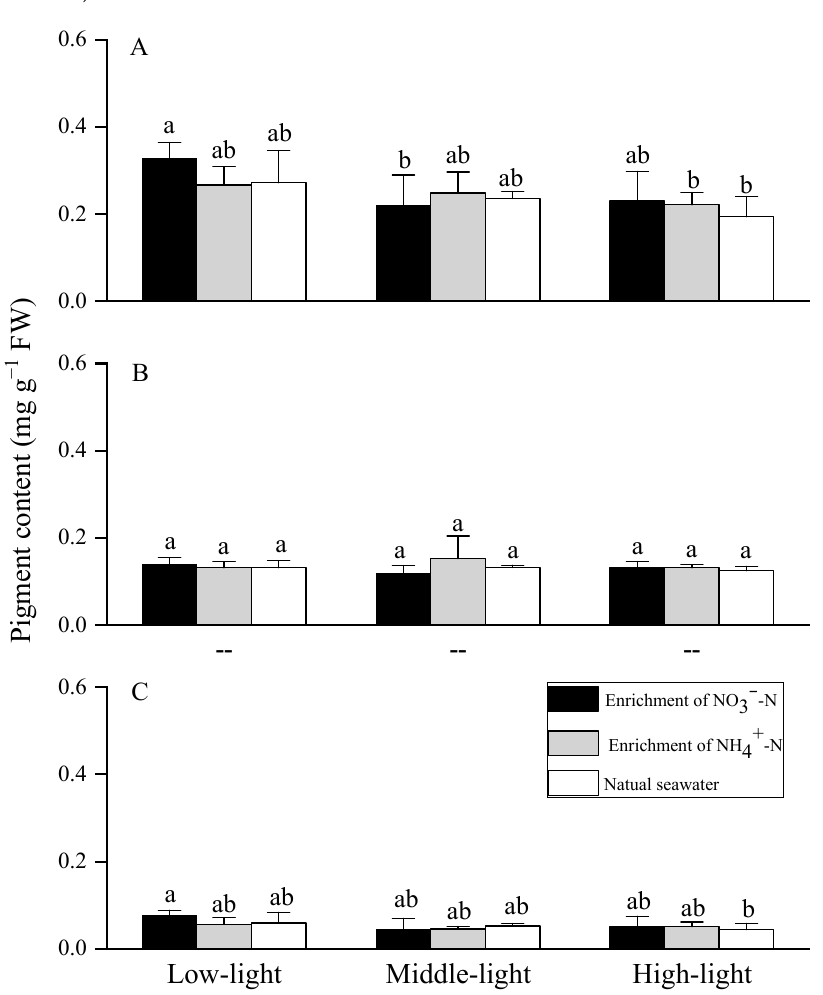
Figure 4. Pigment content ( A , Chl a; B , Chl c; C , Car) of S. horneri after being grown at different light and N conditions for 10 days. Data are reported as means ± SD (n = 3). Different letters above the error bars indicate significant differences between treatments ( P <